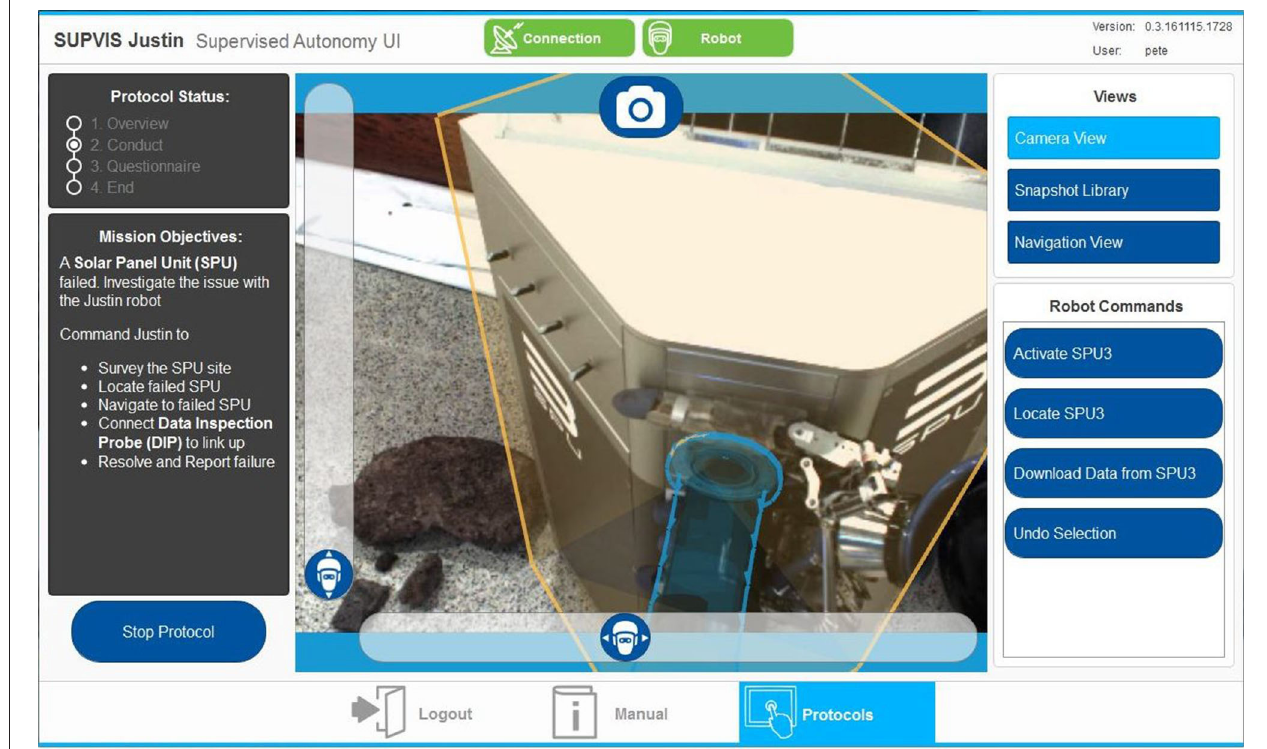
FIGURE 7 | An example layout of the knowledge-driven intuitive tablet user interface on board the ISS (Lii et al., 2018).